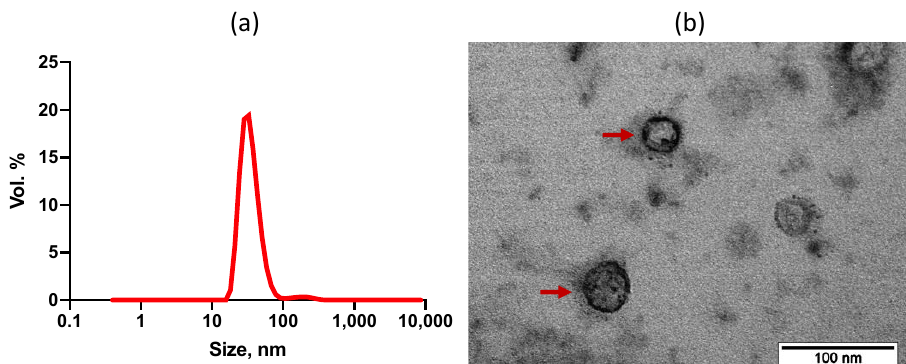
Figure 3. ( a ) Dynamic light scattering analysis of EncA_PAmCherry (34 ± 4 nm; PDI 0,22). Hydrodynamic size of Mx encapsulins, volume distribution. ( b ) Bright-field TEM image of Uranyless -stained EncA_PAmCherry, red arrows indicate Mx encapsulins protein shells, scale bar 100 nm. Isolated encapsulins containing PAmCherry label were added to RAW 264.7 cells.